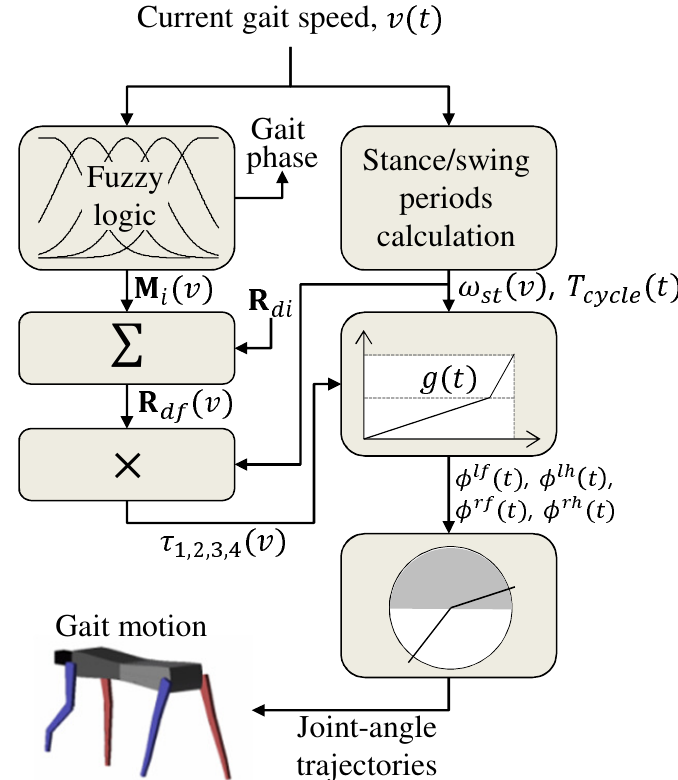
Figure 10. A block diagram of the proposed algorithm.